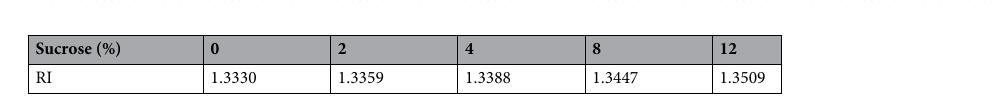
Table 1. RI values of different sucrose dilutions (0% stands for